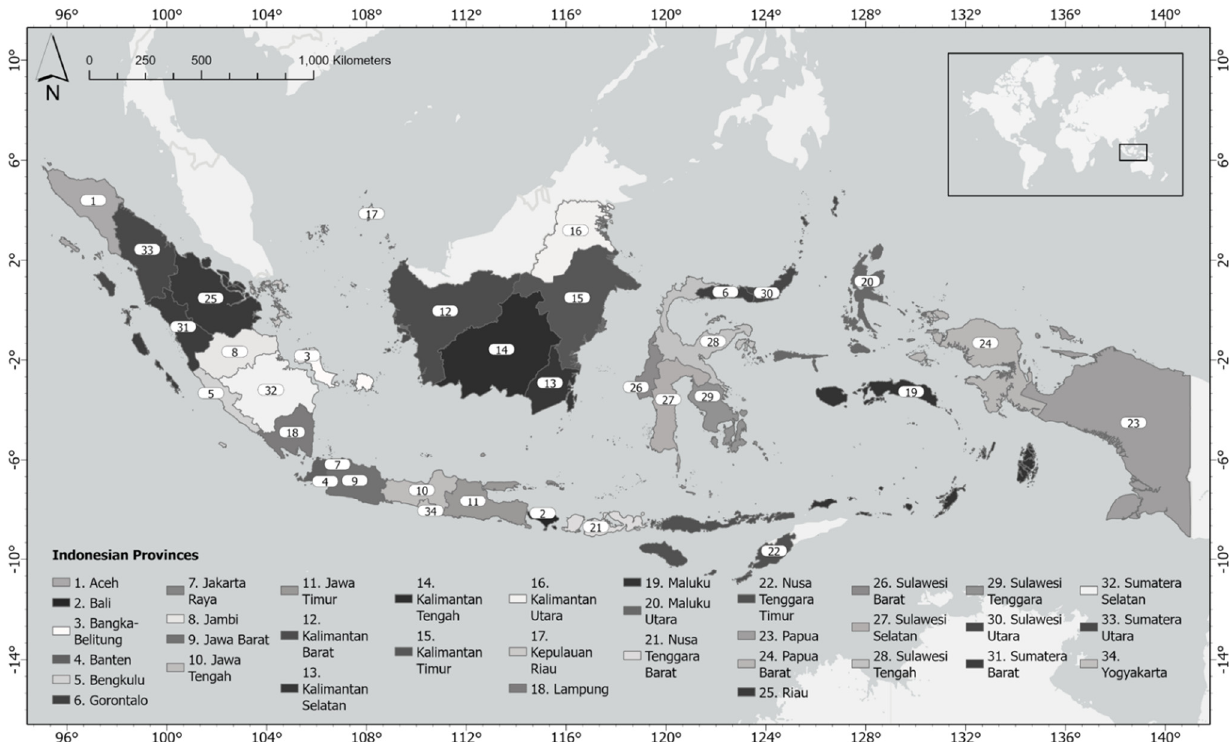
Figure 1. The provinces in Indonesia. Please consult this map to understand the whereabouts of certain stranding hotspot locations throughout this paper; subsequent maps will not contain provincial names for visual clarity. At the end of June 2022, the Province of Papua (#23) was divided into three new provinces, but no shapefiles were yet available to update #23 into three new provinces as of the end of July 2022.